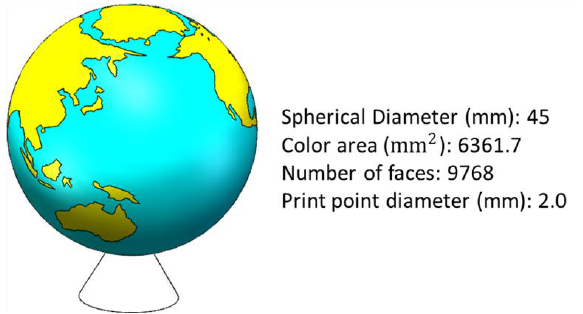
Figure 13. The Earth model. Table 1. Comparison between the adaptive filling algorithm based on the section method (AFSM) and OCPP for a revolving surface.